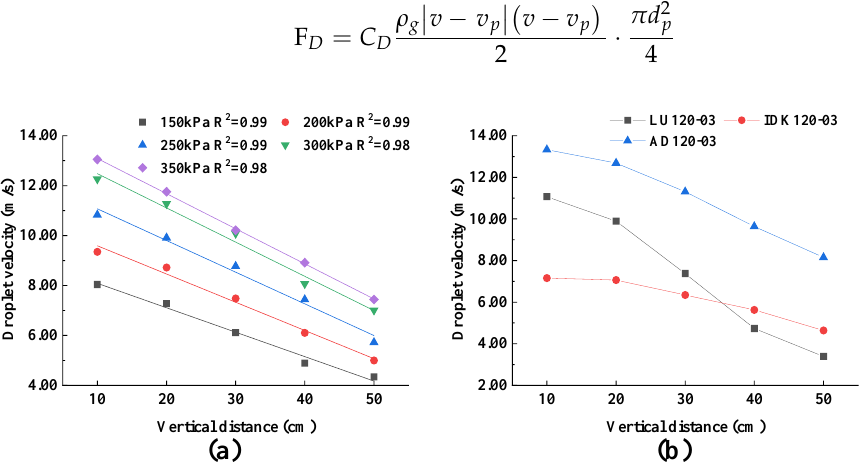
Figure 8. Distribution of droplet velocity V Z on Z axis. ( a ) different pressure ( b ) different nozzles